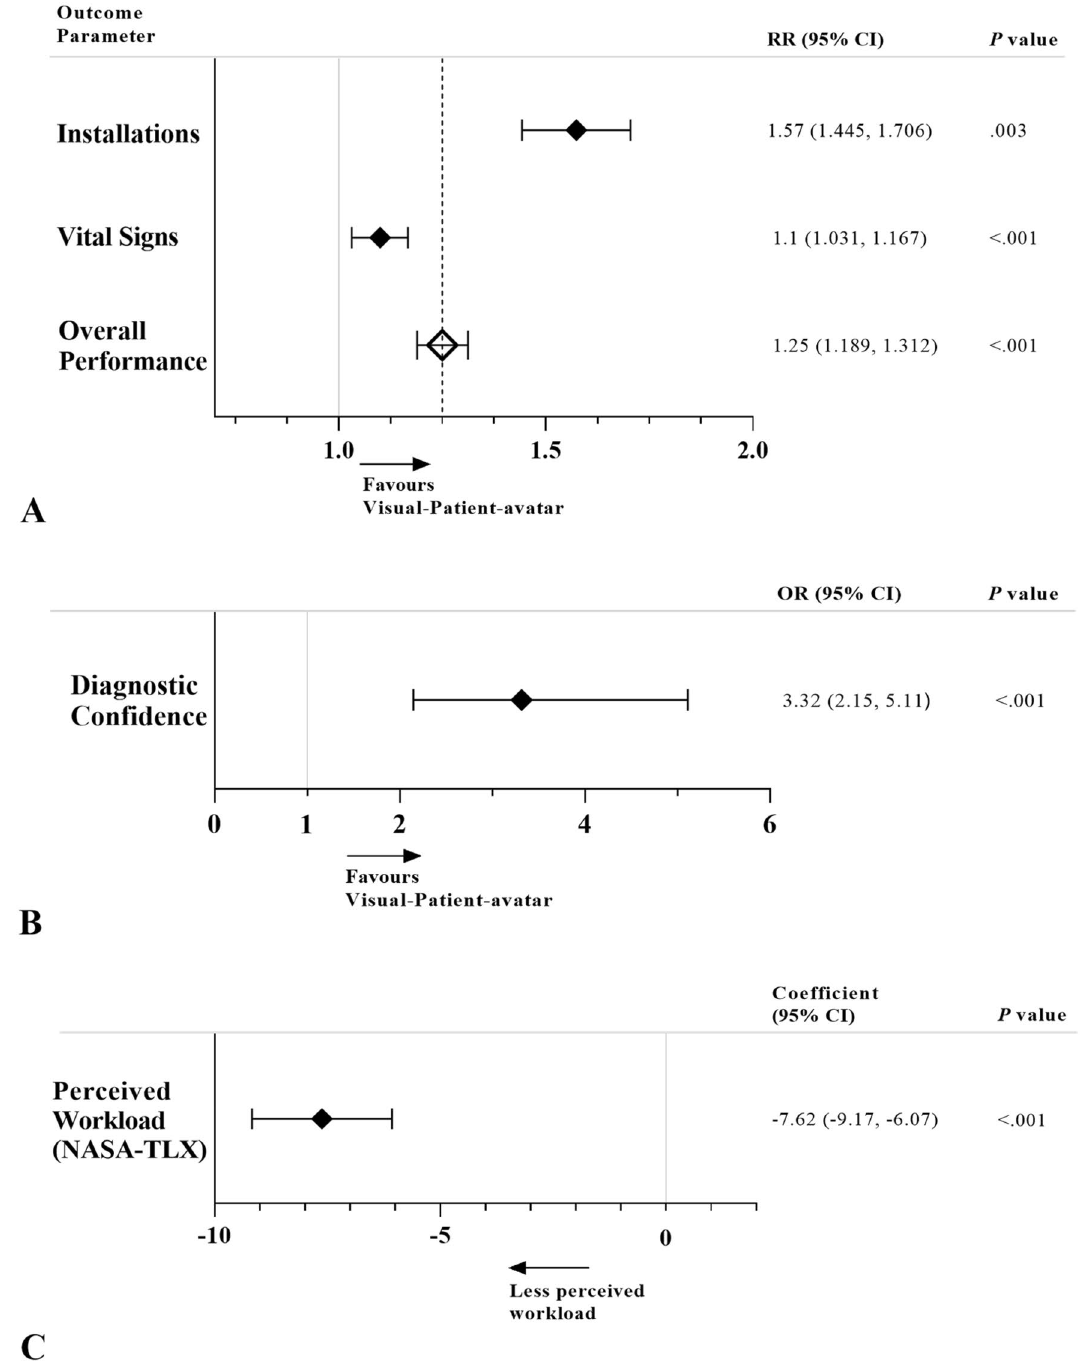
Figure 4. Graphical presentation of results for all outcome parameters. ( A ) Mixed Poisson regression model of correct answers relating vital signs and installations for Visual-Patient-avatar ICU and conventional monitor. Rate ratios (RR) are shown by squares and whiskers indicate the 95% confidence interval. ( B ) Mixed logistic regression model for diagnostic confidence of Visual-Patient-avatar ICU and conventional monitor. Odds ratio (OR) is shown by square and whiskers indicate the 95% confidence interval. ( C ) Mixed linear regression model for perceived workload of Visual-Patient-avatar ICU and conventional monitor. The coefficient is shown by square and whiskers indicate the 95% confidence interval. NASA-TLX National Aeronautics and Space Administration Task Load